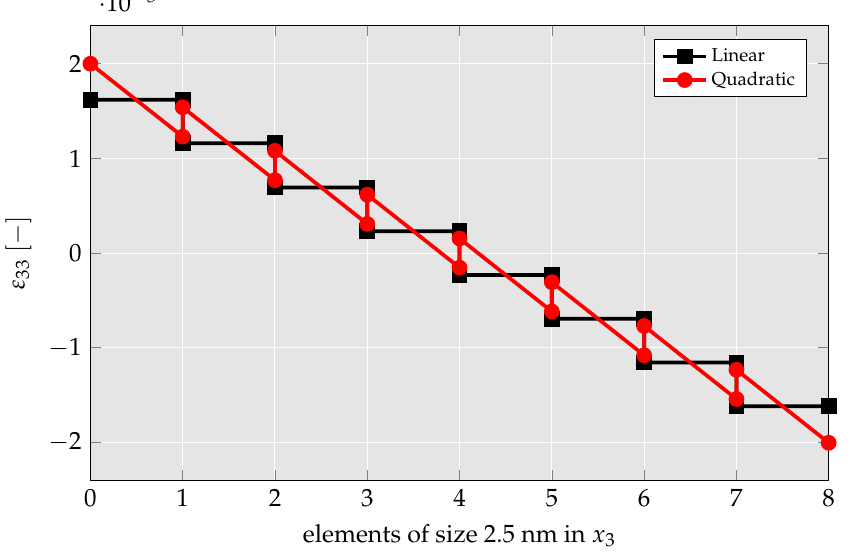
Figure 27. Discontinuous strain ε 33 for linear and quadratic element across the height of the cantilever